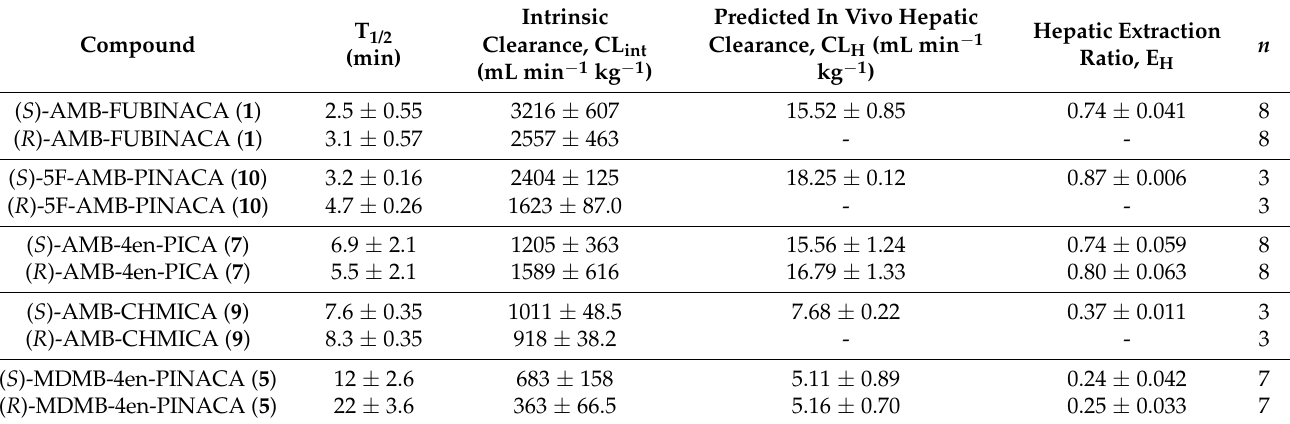
Table 5. In vitro half-life and intrinsic clearance (CL int ) with predicted in vivo hepatic clearance (CL H ) and hepatic